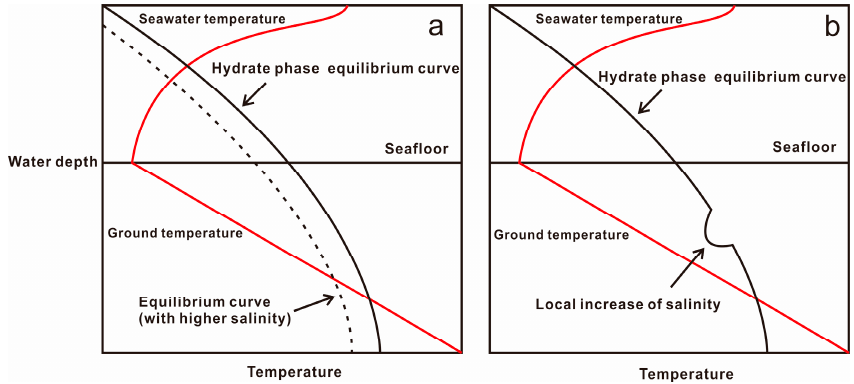
Figure 8. Effect of salinity on the phase equilibrium of hydrate. ( a ): change of equilibrium curve with higher salinity; ( b ): potential influence of local increase of salinity.